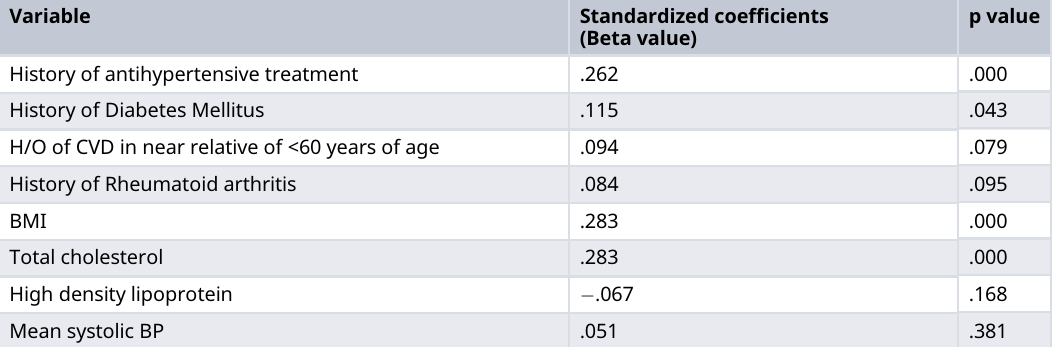
Table 4. Multiple regression analysis with K-L Grade of knee OA as dependent